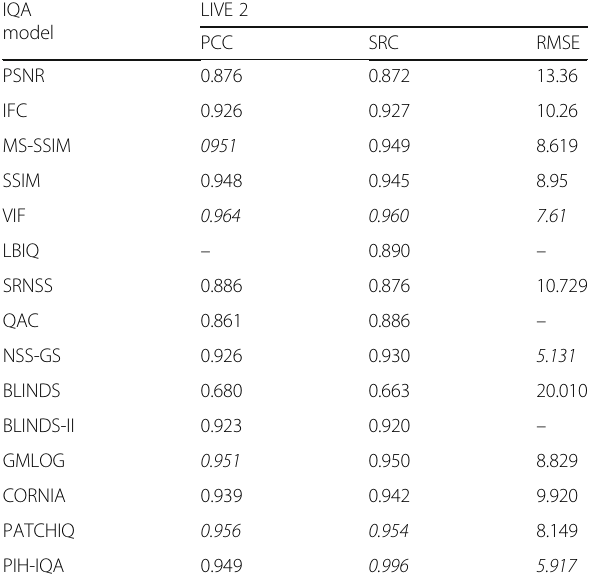
Table 1 Performance of the proposed PIH-IQA and the other competing models